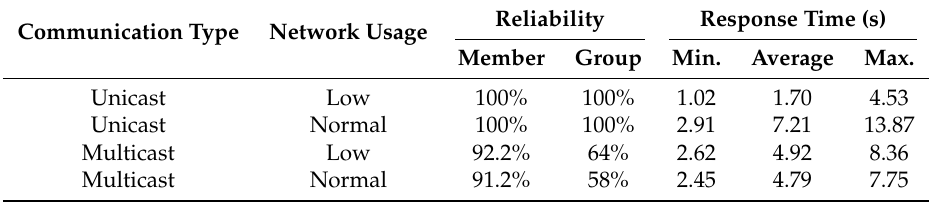
Table 8. Summary of the results of the experiments on the w-iLab.t office wireless sensor testbed.